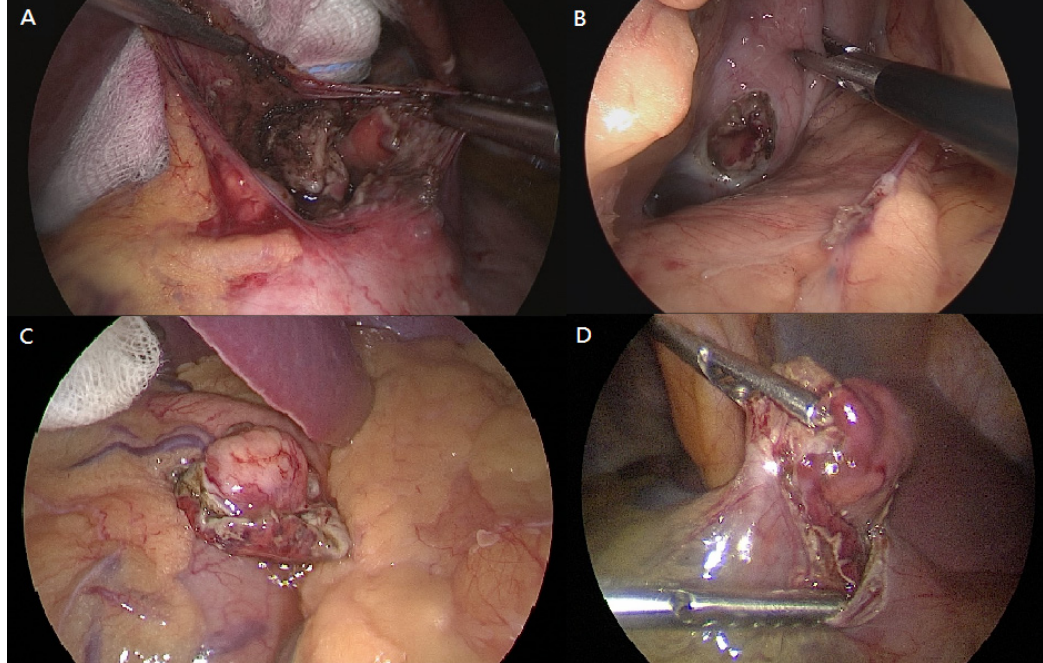
Figure 1. Different perforation sites of the stomach after endoscopic resection: ( A ) at the cardia, ( B ) at the posterior fundus, ( C ) at the greater curvature of fundus with incomplete resection, ( D ) at the anterior antrum with incomplete resection.